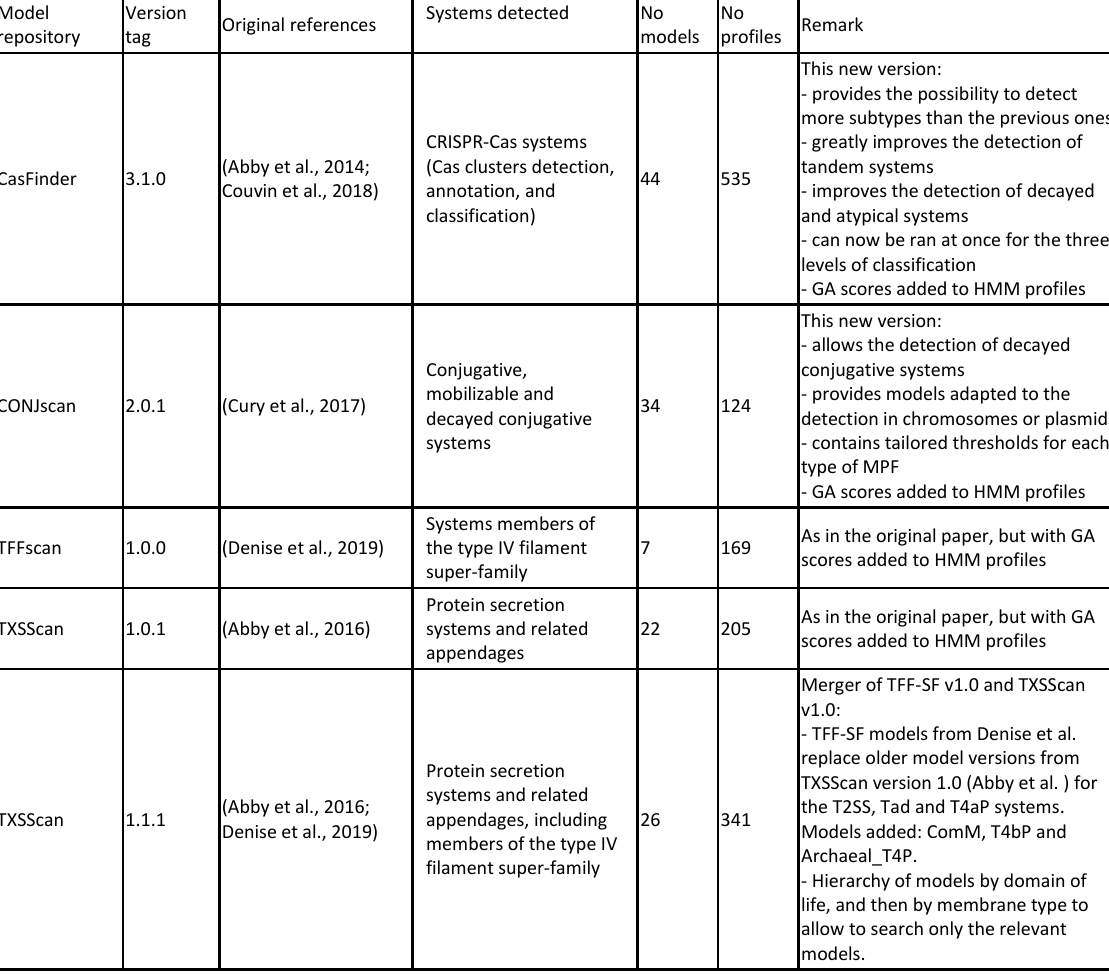
Table 1. Overview of MacSyFinder v2 macsy-model packages available at the “MacSy models” organization https://github.com/macsy-models